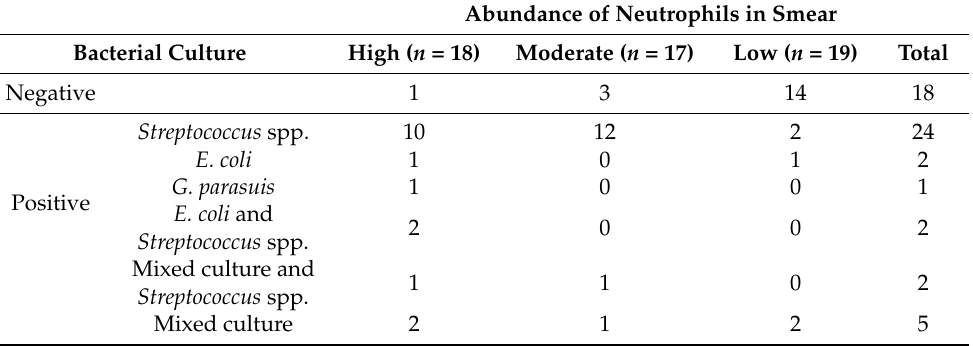
Table 1. Abundance of neutrophils in cytologic impression smears from leptomeninges of pigs ( n = 54) in relation to the results of bacterial